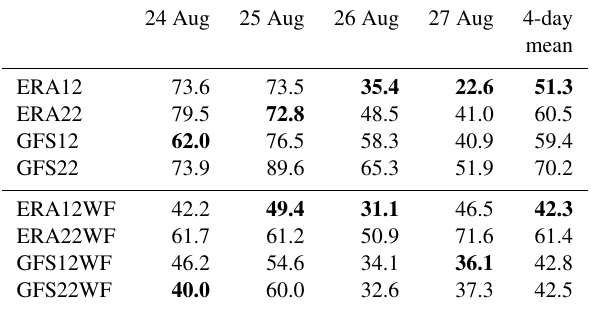
Table 5. Average bias of 10min total power (MW) of different model runs each day.